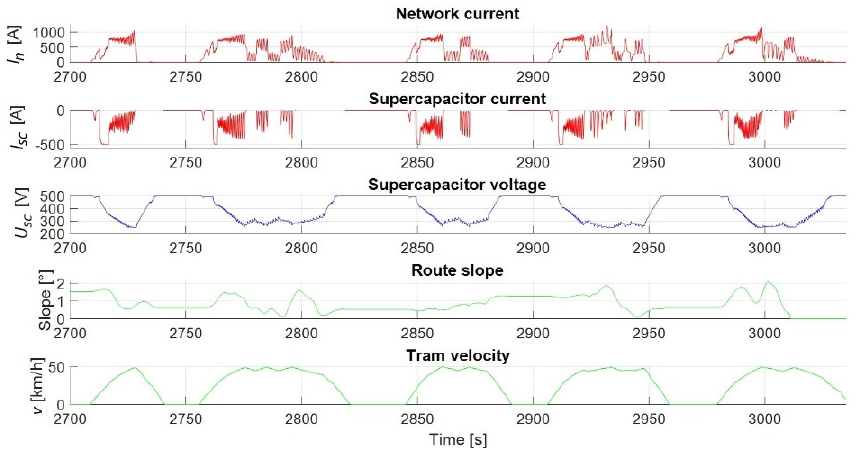
Figure 23. Enlarged view of the critical track section. Table 5. Power grid energy saving and current grid reduction using the minimum energy algo- rithm.